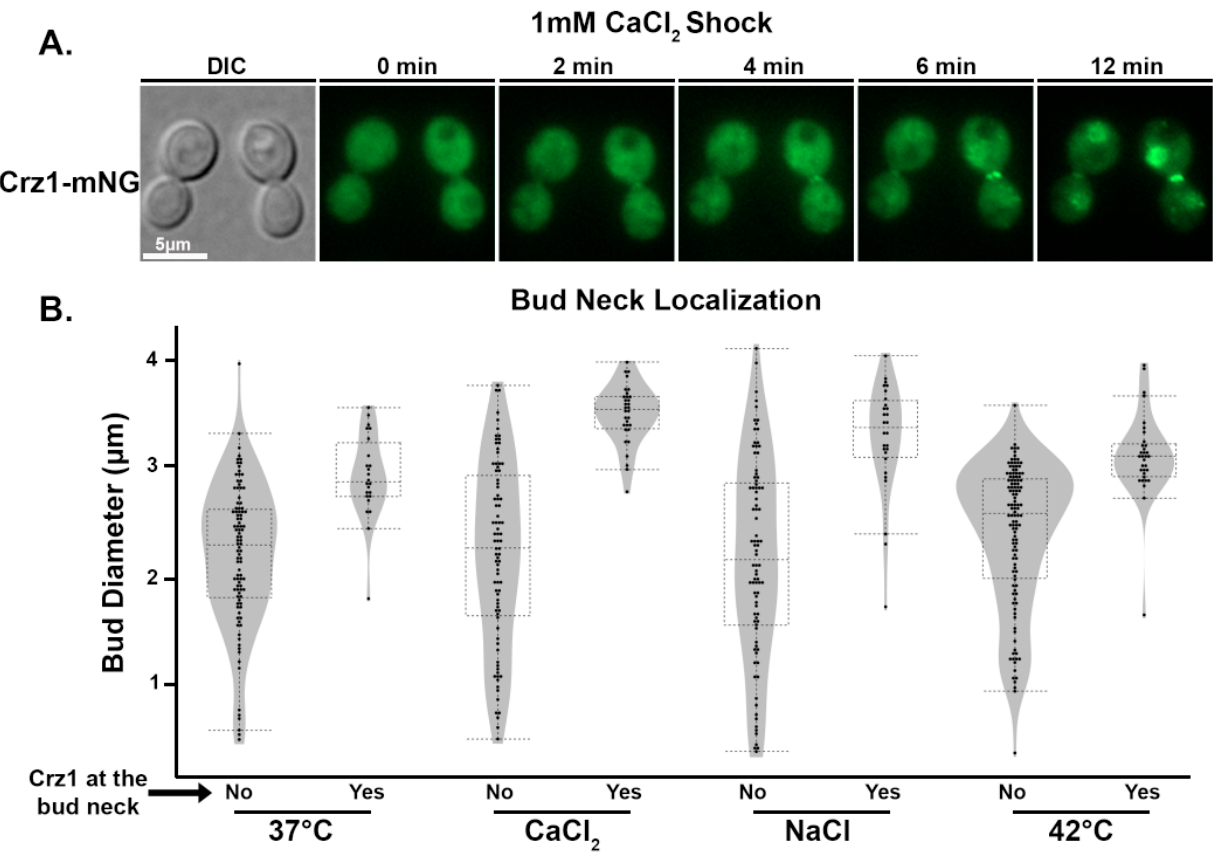
Figure 4. Crz1 localizes to the bud neck in response to stress. ( A ) Cells expressing Crz1-mNeonGreen were suspended in 1 mM CaCl 2 on a microscope slide and immediately imaged. The same field of view was captured at the indicated times and representative images are shown. ( B ) Cells with buds were characterized as having Crz1-mNG localization at the bud neck or not. The diameter of each bud was measured using ZEN 3.1 software. Over 100 cells were quantified per condition tested.